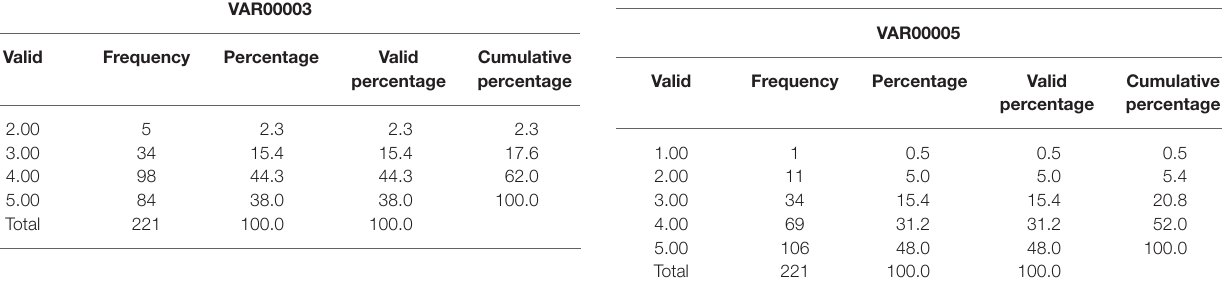
TABLE 5 | Activity has motivated me because it has enabled me to contribute my knowledge.